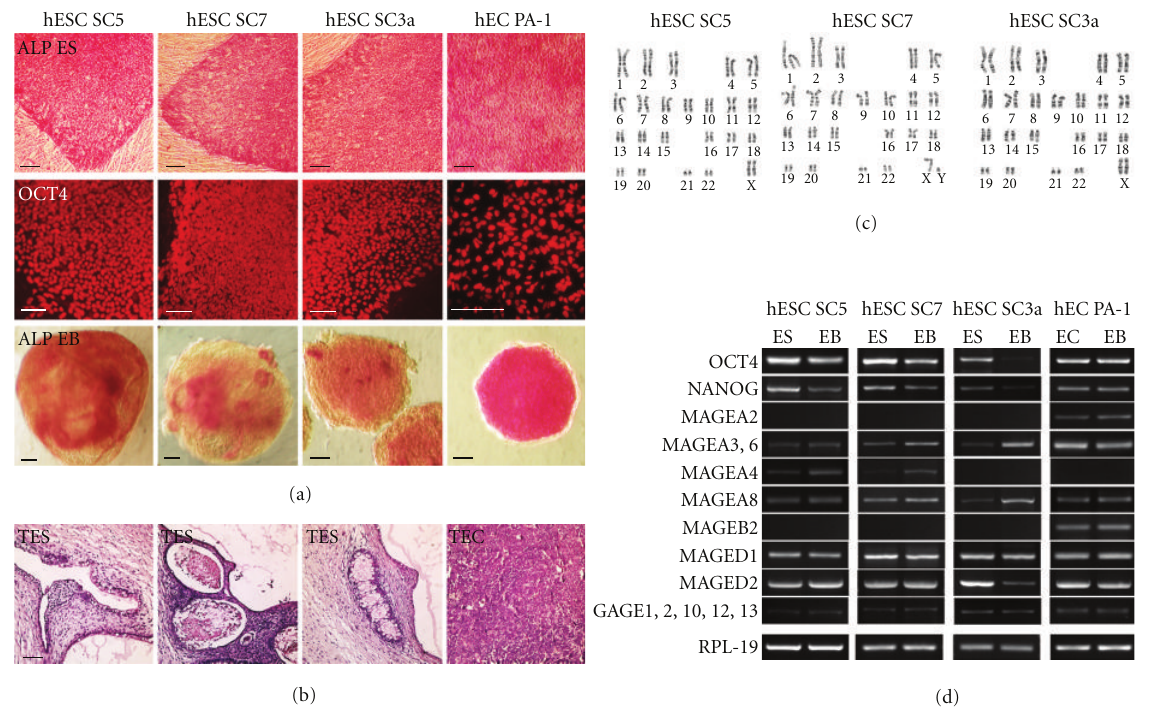
Figure 2: CTA expression patterns in hES SC5, SC7, and SC3a cells and hEC PA-1 cells. (a) Activity of alkaline phosphatase and OCT4 in undi ff erentiated hES and hEC cells and in EBs formed by these cell lines. Scale bar = 100 μ m. (b) Histological sections through teratomas and teratocarcinomas formed by hES and hEC cell lines. Cell derivatives of three germ layers were found in teratomas (TES) formed by hES cells and entirely cancer cells in teratocarcinomas (TEC). Scale bar = 100 μ m. (c) Normal diploid karyotypes of hES SC5, SC7, and